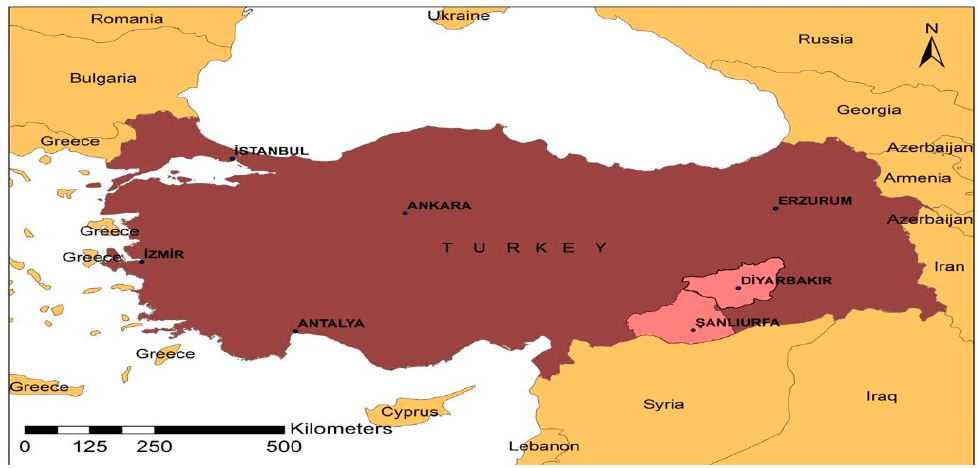
Figure 1. The location of Ş anl ı urfa and Diyarbak ı r in Turkey (Source: Prof. Dr. Mehmet Ali Çullu).